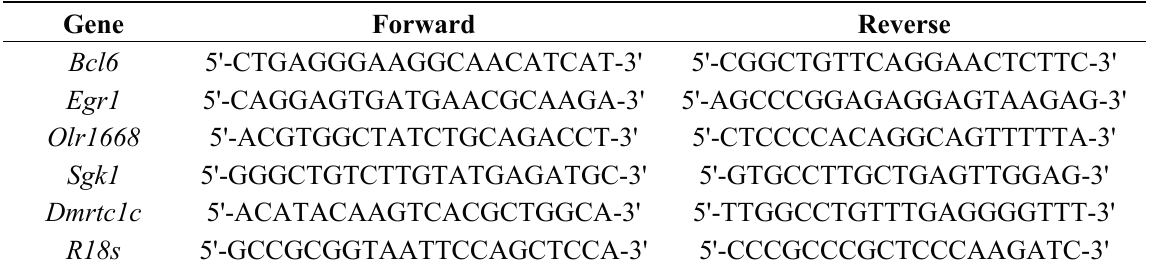
Table 5. qPCR primers